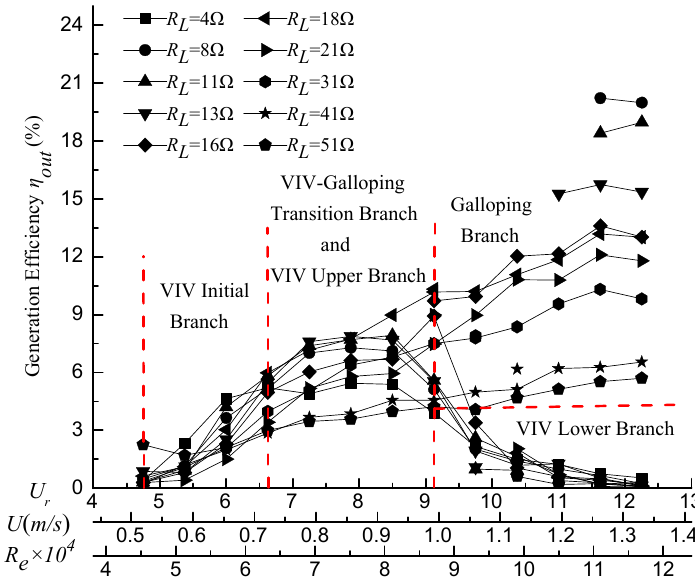
Figure 15. T-section prism power generation efficiency.